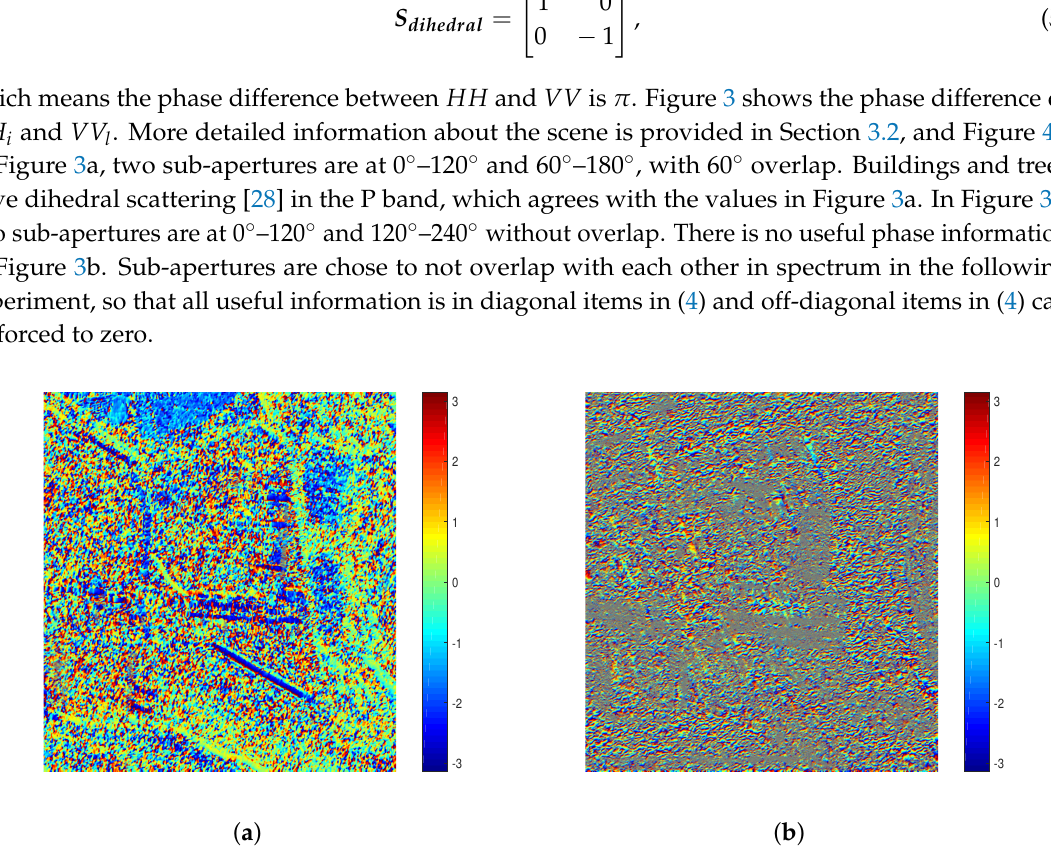
Figure 3. Phase difference of HH i and VV l , with HH i from the i th, and VV l from the l th subaperture. The two sub-apertures: ( a ) have overlap; and ( b ) do not have overlap.